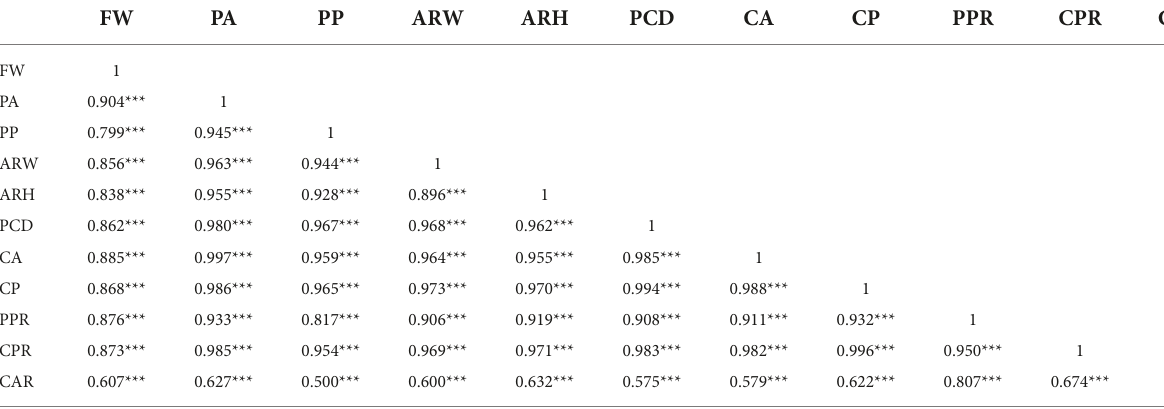
TABLE 4 Correlation coefficients between fresh weight and geometric traits of lettuce.